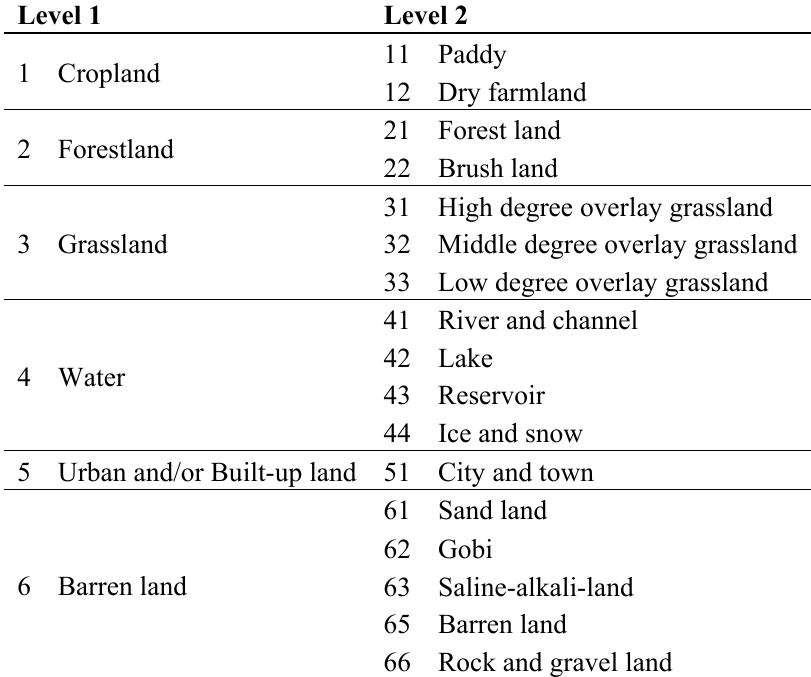
Table 2. The Chinese Land Resource Classification